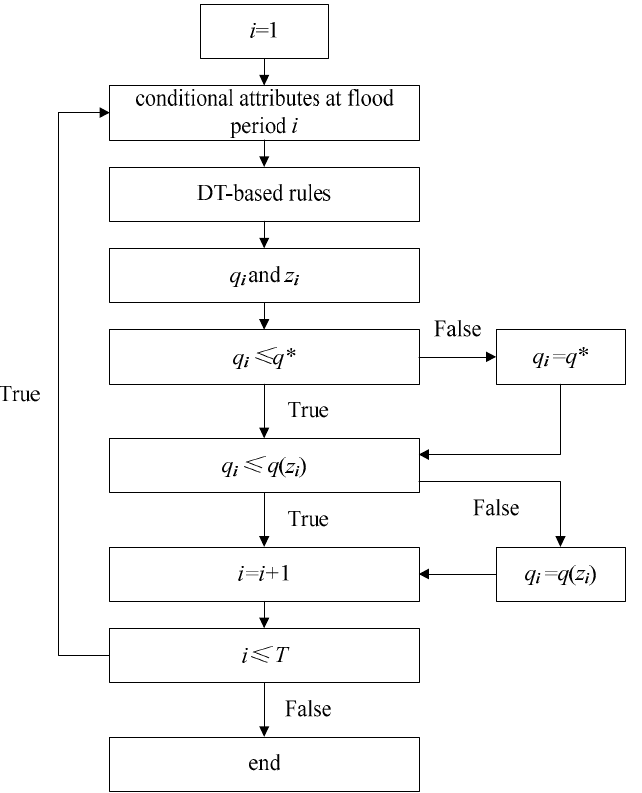
Figure 1. The flowchart of the real-time reservoir operation procedure using DT-based